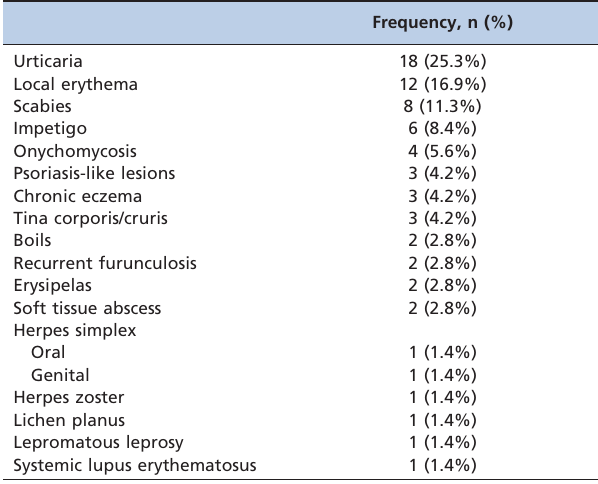
Table 1 - The frequency of 71 new CAEs in 257 patients with chronic inflammatory arthritis taking TNF- a blockers after 60 months of follow-up.